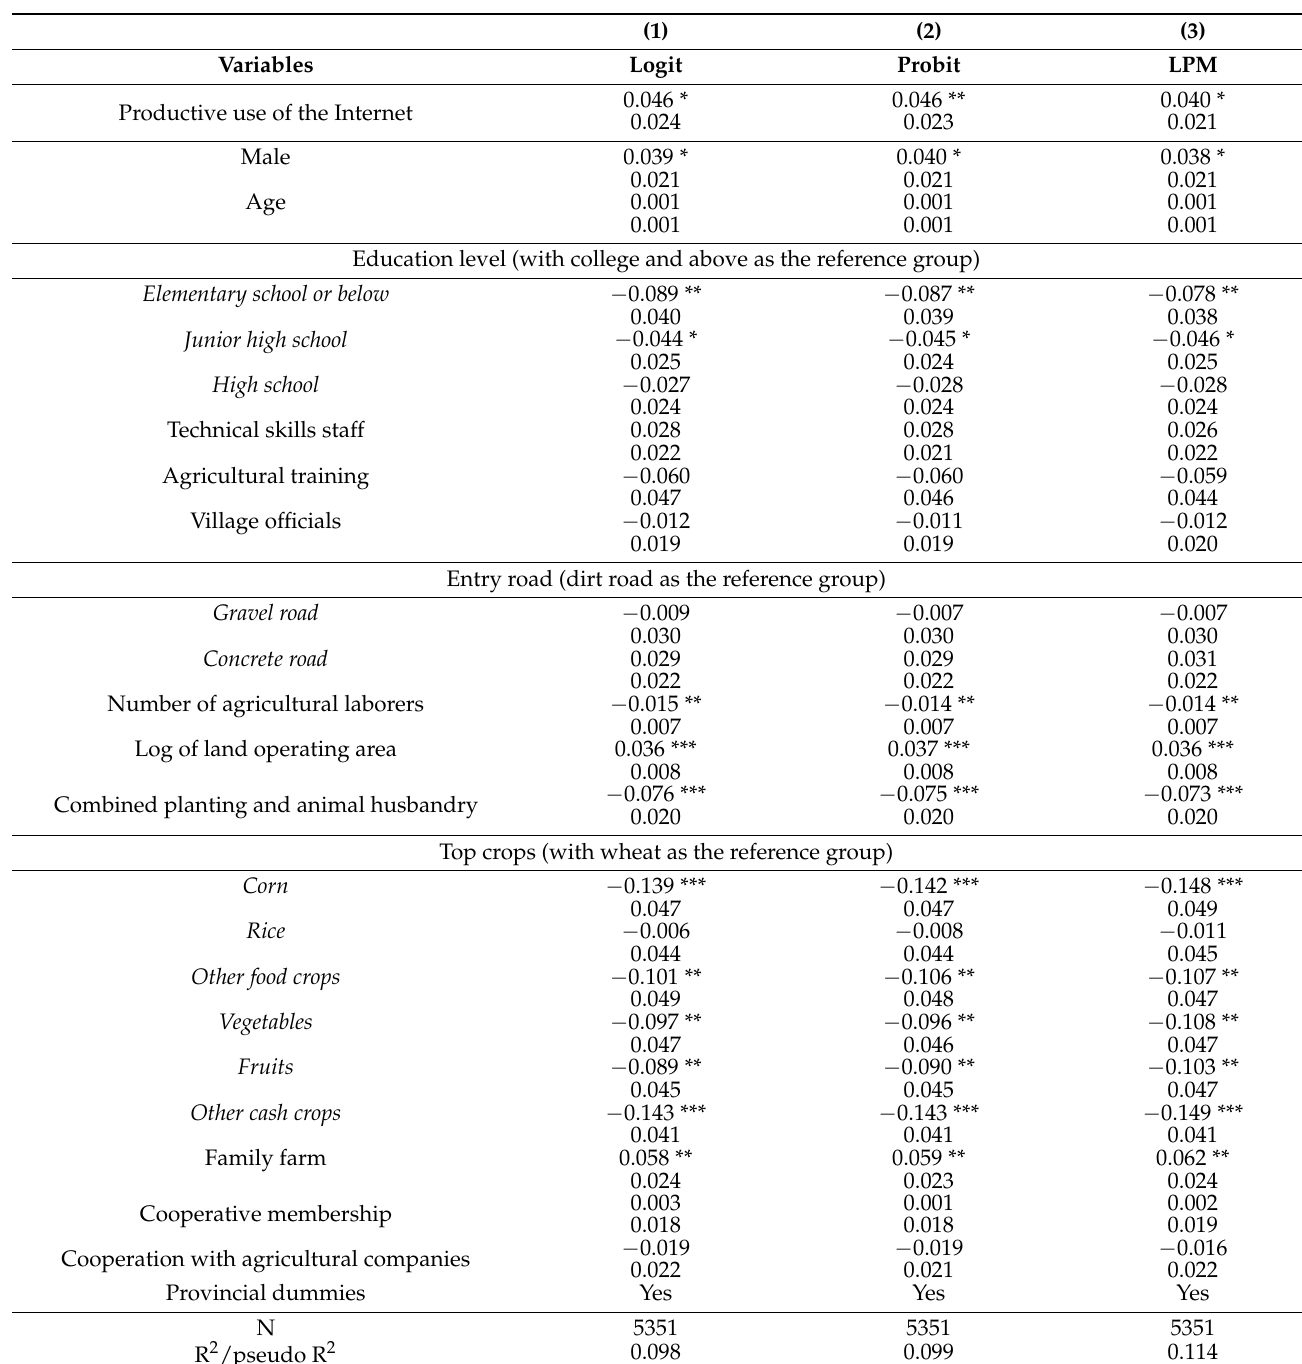
Table 3. The marginal effect of different variables on the adoption of soil testing and formulated fertilization technology from Logit, Probit, and LPM